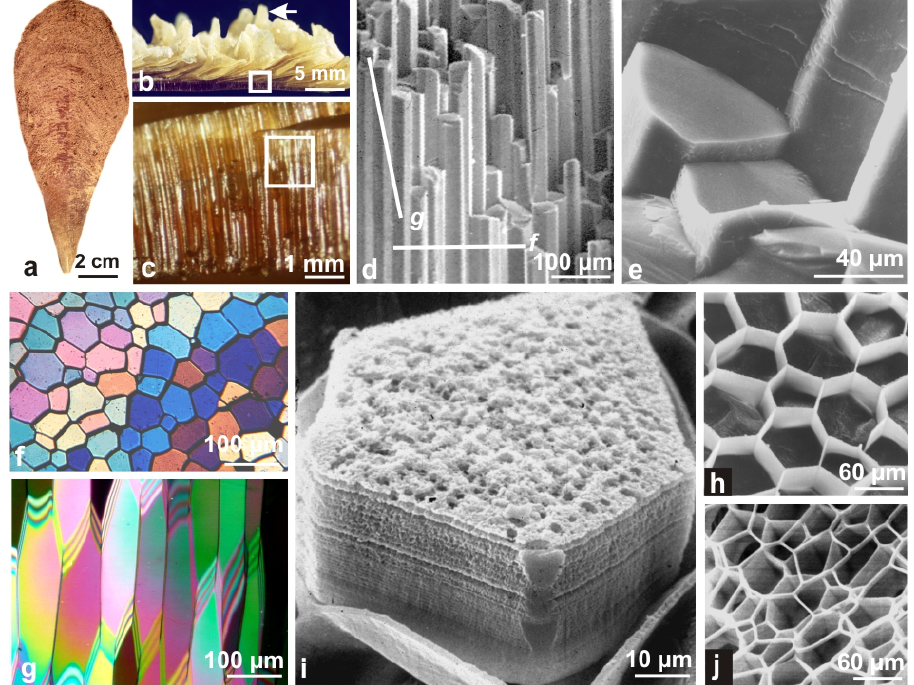
Figure 1. Layered growth in the prisms of the mollusk pelecypod Pinna : the historical reference for biocrystals . a – e : The building units of the outer layer of the Pinna shell ( a , b ) are closely assembled linear polygonal prisms ( c , d ) with massive aspect of fractures ( e ); ( f , g ) Thin sections observed under the microscope between cross-nicols. Owing to the high refractive index of calcite, such primary colors are obtained far below the standard thickness: here about 5–6 micrometers. Note the homogeneity of color for each prism on the transverse section ( f ). Difference in color from prism to prism, results from variation of orientation of the crystallographic c axis (the elongation axis of the prism). When prisms are sectioned in length, color is more variable because obliquity of the sections with respect to elongation axis creates variations in the thickness with the possibility of superposed contributions of two prisms; ( h ) Strong acidic etching: the polygonal network of prism envelopes has been made free; ( i ) Layered growth visible without any preparative process of the lateral side of the mineralized unit. Note also the granular aspect of the growth surface; ( j ) After a one week decay in water the polygonal network corresponding to a single growth layer has been freed (and slightly displaced) from underlying